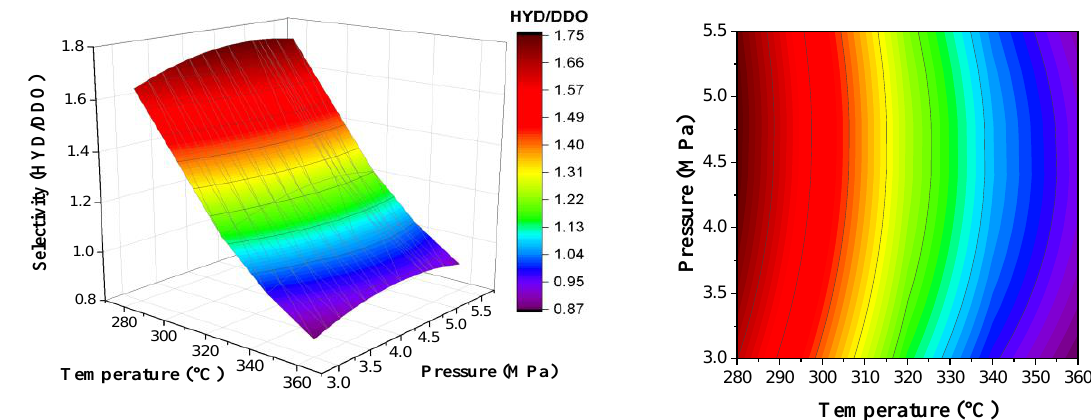
Figure 8. Response surface curve ( left ) and contour surface plot ( right ) correspond to the selectivity as a function of the reaction temperature and pressure for the HDO of phenol over a CoMo/AT2 material with a Mo loading of 12 wt.%. Table 1. The effect of operational temperature on the initial reaction rate of phenol using a Co- MoS/AT2 material with a Mo loading of 12 wt.% and operational pressure of 5.5 MPa. Temperature ◦ C